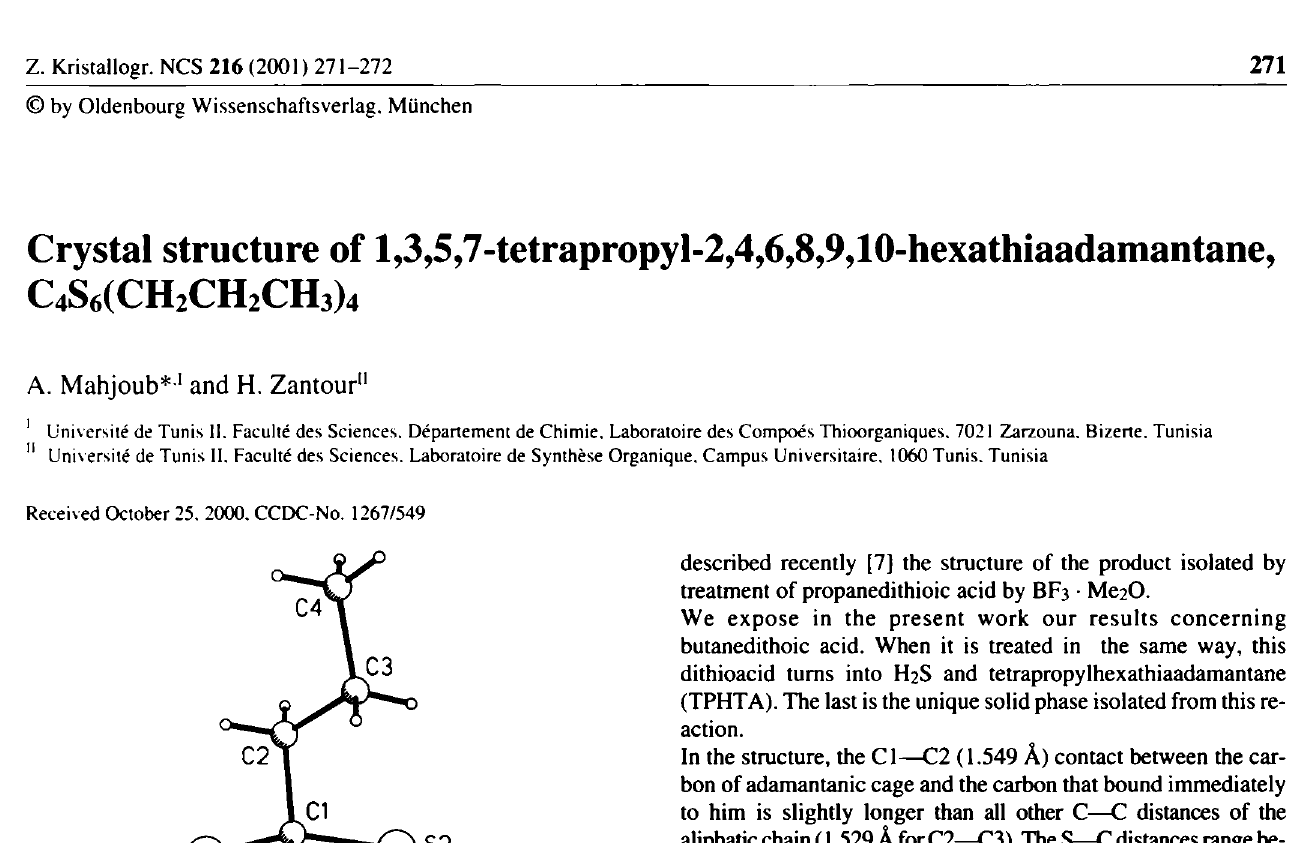
Table 1. Data collection and handling.